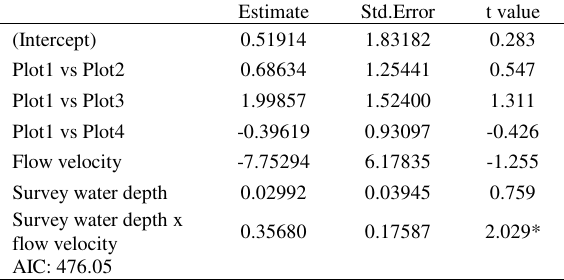
Table 2. Variables in GLM for the effect of water depth, flow velocity and their interaction on the accuracy of